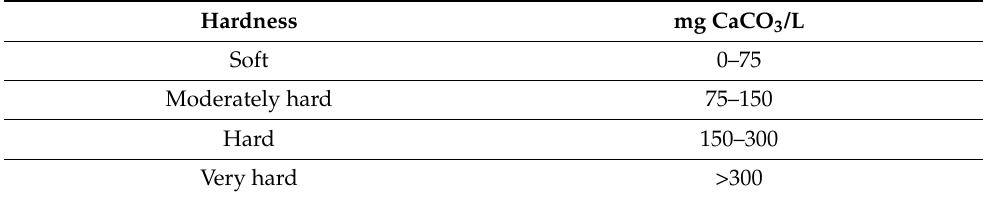
Table 1. Relative hardness of waters